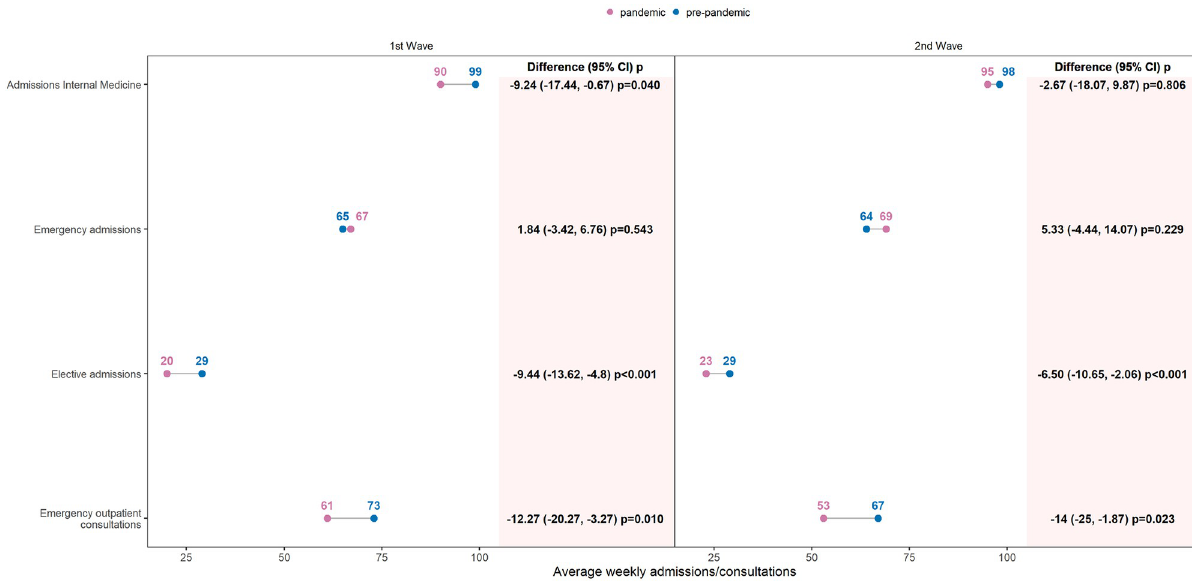
Fig 1. Yearly changes in pandemic year (2020) weekly admissions and emergency outpatient consultations, compared to pre-pandemic years (2017–2019). Connected dots represented the average number of weekly admissions and emergency outpatient consultations in pre-pandemic versus pandemic period during the two pandemic waves. Differences between the two means and 95% bootstrap Confidence Interval (CI) with p-values (robust t-test) were indicated in columns. 1st Wave: calendar weeks (10–24); 2nd Wave: calendar weeks (39–53).